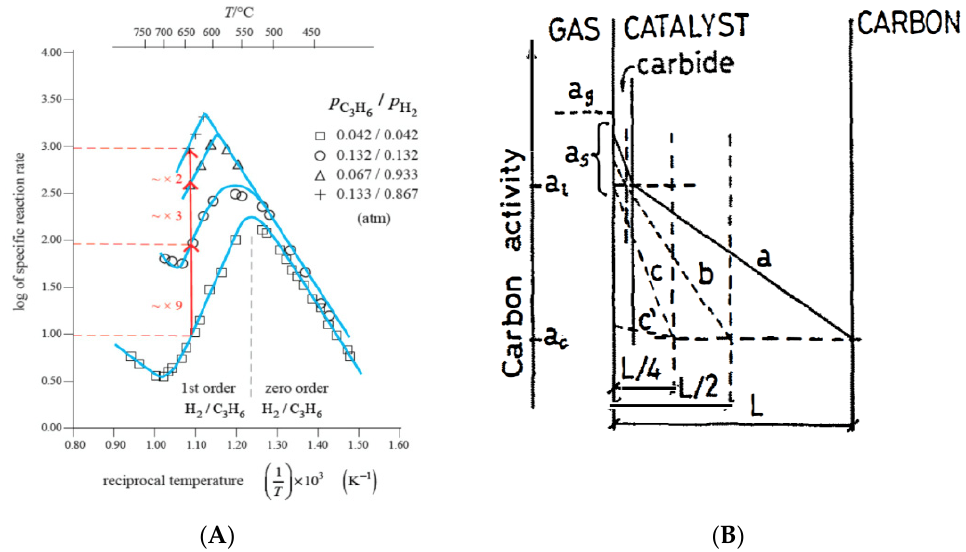
Figure 4. ( A ) Experimental results measured with a vacuum microbalance (Arrhenius plot) proving a C bulk diffusion mechanism and the change or rate determining step at 550–600 °C. Reprinted from [51] with permission from MDPI. ( B ) Carbon bulk diffusion through the catalyst bulk during CNT growth: Carbon concentration/activity profiles through the catalyst for three different diffusion paths. The phase thicknesses are stable during reaction. With Ni, the metal is the main phase during CNTs formation, but with Fe and steel, the main stable phase with graphite is a carbide (usually Fe 3 C). Reprinted from [9] with permission from